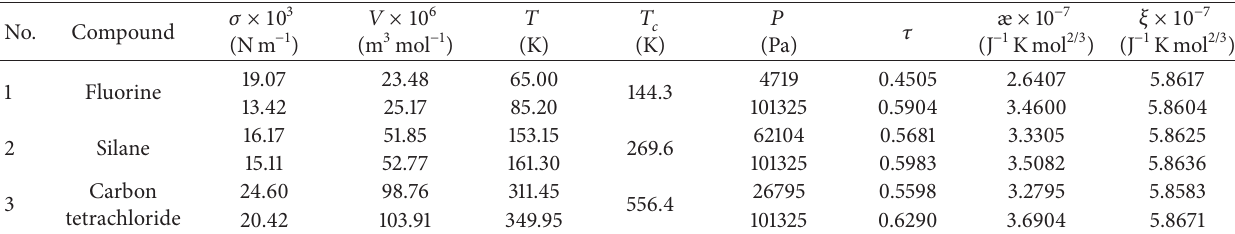
Table 1: To the definition of the temperature dependence of æ.